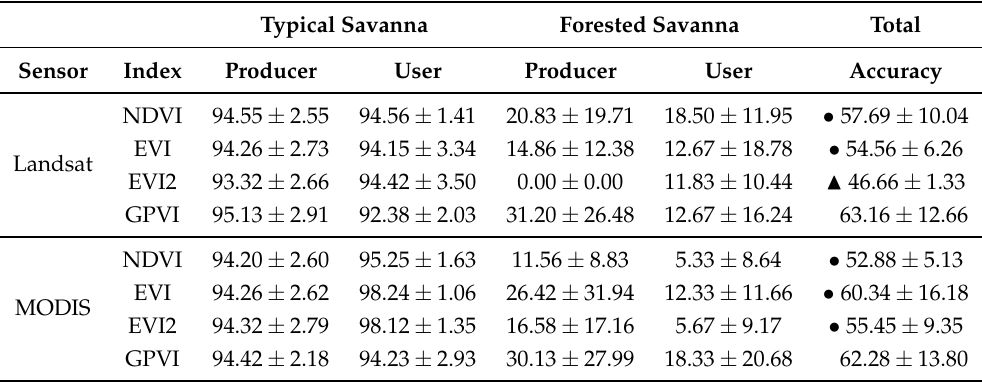
Table 8. Normalized accuracies and user’s and producer’s accuracies per class for typical savanna/forested savanna time series discrimination. (cid:78) means that GPVI was statistically superior to the corresponding baseline; (cid:72) , which it was statistically inferior, and • , which both methods were tied. Typical Savanna Forested Savanna Total